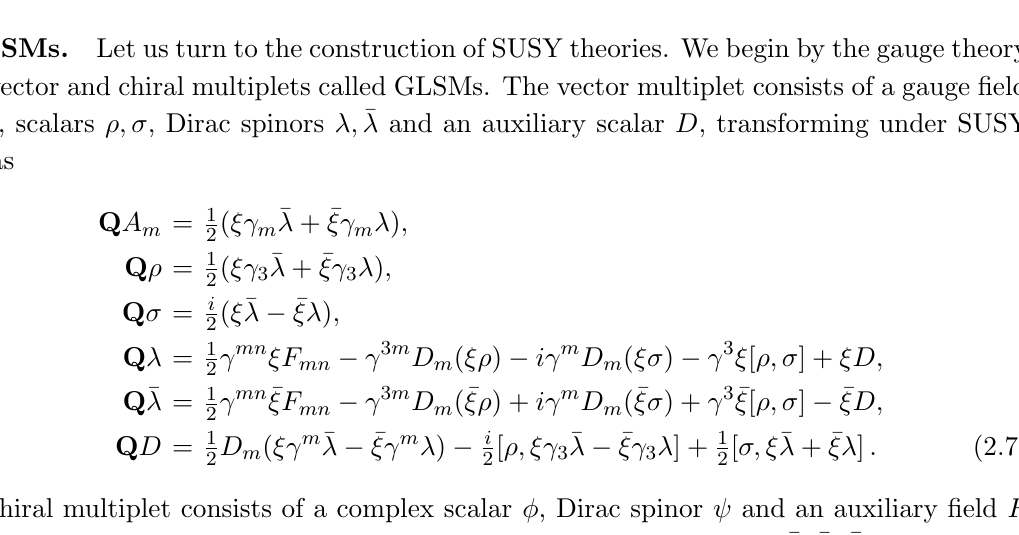
Table 1 . The vector R-charges of (cid:12)elds in a